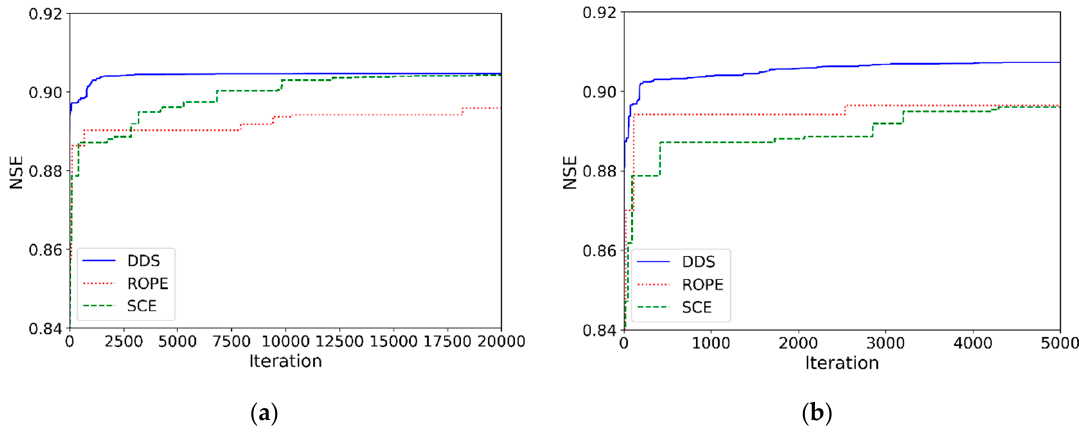
Figure 8. Comparison of convergence rates measured by Nash–Sutcliffe efficiency (NSE) between the three optimization algorithms at Station 1,002,640 (( a ) 20,000 iterations and ( b ) 5000 iterations).